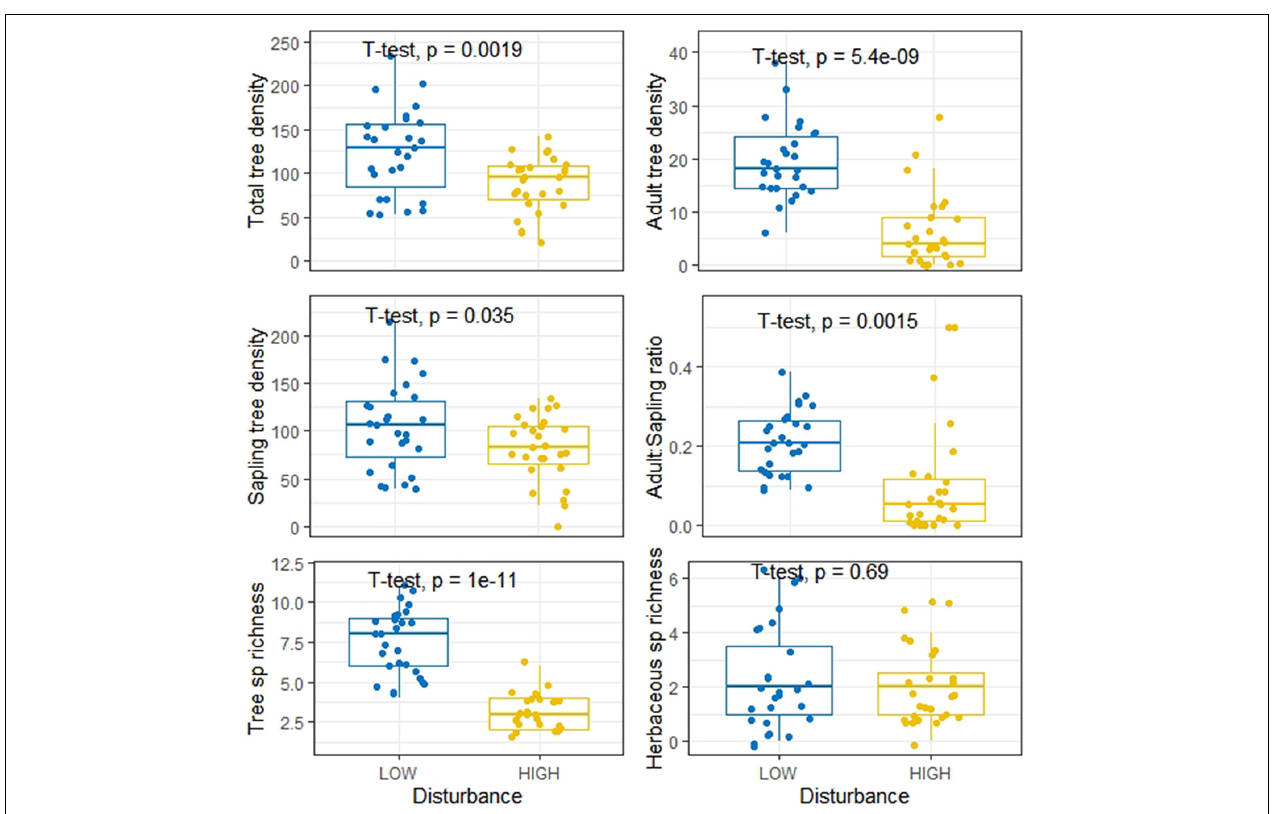
FIGURE 4 | Boxplot showing distribution of total tree density, adult tree density, sapling tree density, adult:sapling ratio, tree species richness, and herbaceous species richness at low and high disturbed